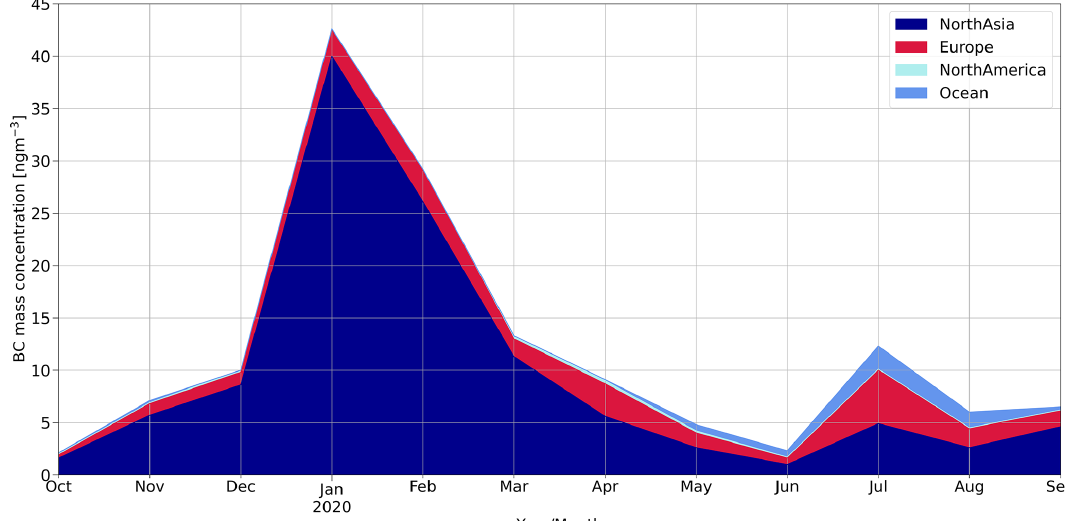
Figure 8. Simulated source regions of anthropogenic BC concentrations from the ECLIPSE emission inventory. The BC mass concentrations are presented as monthly averages for each of the source regions using the FLEXPART simulations and the ECLIPSE v6b emission inventory. The source region definitions correspond to the geographical source region mask as shown in Fig.